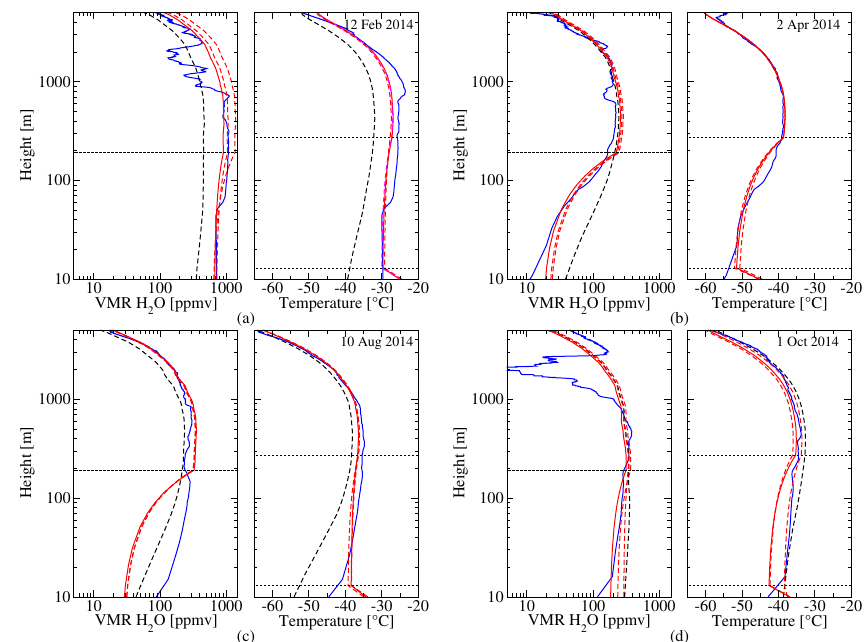
Figure 9. Comparison of the retrieved profiles of the water vapour VMR and temperature (red continuous and dashed line) for the selected measurements of Fig. 8 with the 12:00UTC radiosounding profiles (blue) and the initial guess (dashed black line). The red continuous lines are related to the profile with better temporal coincidence with the